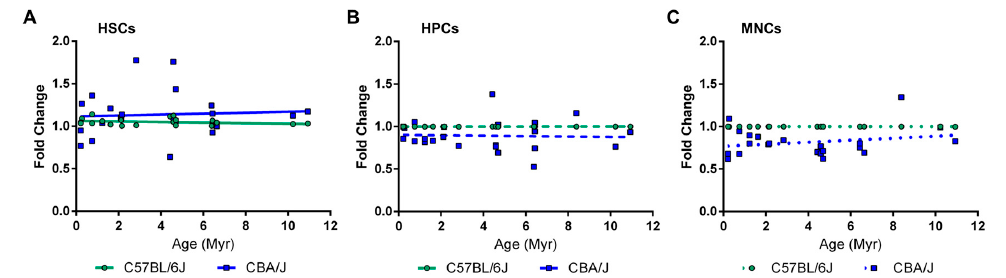
Figure 2. Comparative analysis of LINE-1 5 ′ -UTR DNA methylation in C57BL/6J and CBA/J mice. LINE-1 DNA methylation was measured in ( A ) hematopoietic stem cells ( B ) hematopoietic progenitor cells, and ( C ) mononuclear cells using the adapted method for 500-cell methylation-sensitive real time-PCR (RT-PCR). Data are presented as mean ± SEM ( n = 5) and show the linear regression between DNA methylation and evolutionary age of the element (Myr, million years). Values from C57BL6/J animals were arbitrarily given a value of 1 for the purpose of comparison ( n = 5/group).